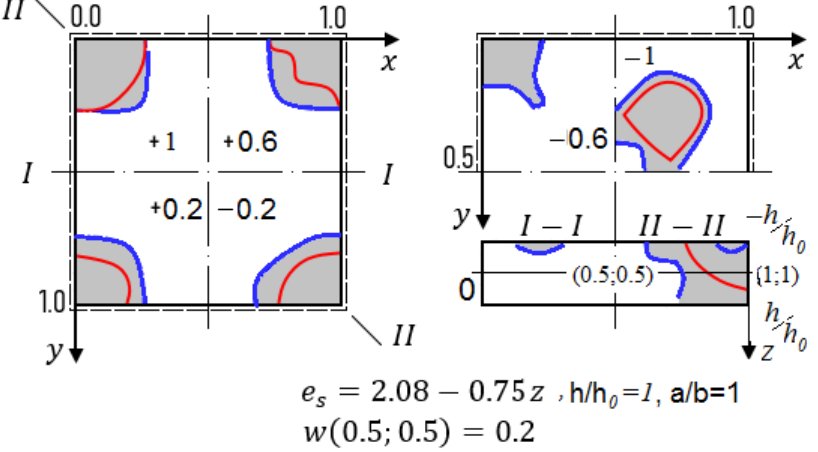
Figure 5. Views of the elastic–plastic deformation with regard to cross-section I–I and cross-section II–II along the shell thickness h = +1; +0.6; +0.2; −0.2; −0.6; −1 for K x = K y = 16.